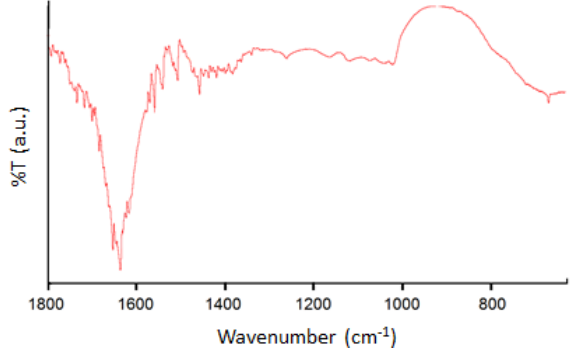
Figure 6. FTIR analysis of the synthesized In 2 O 3 nanoparticles.